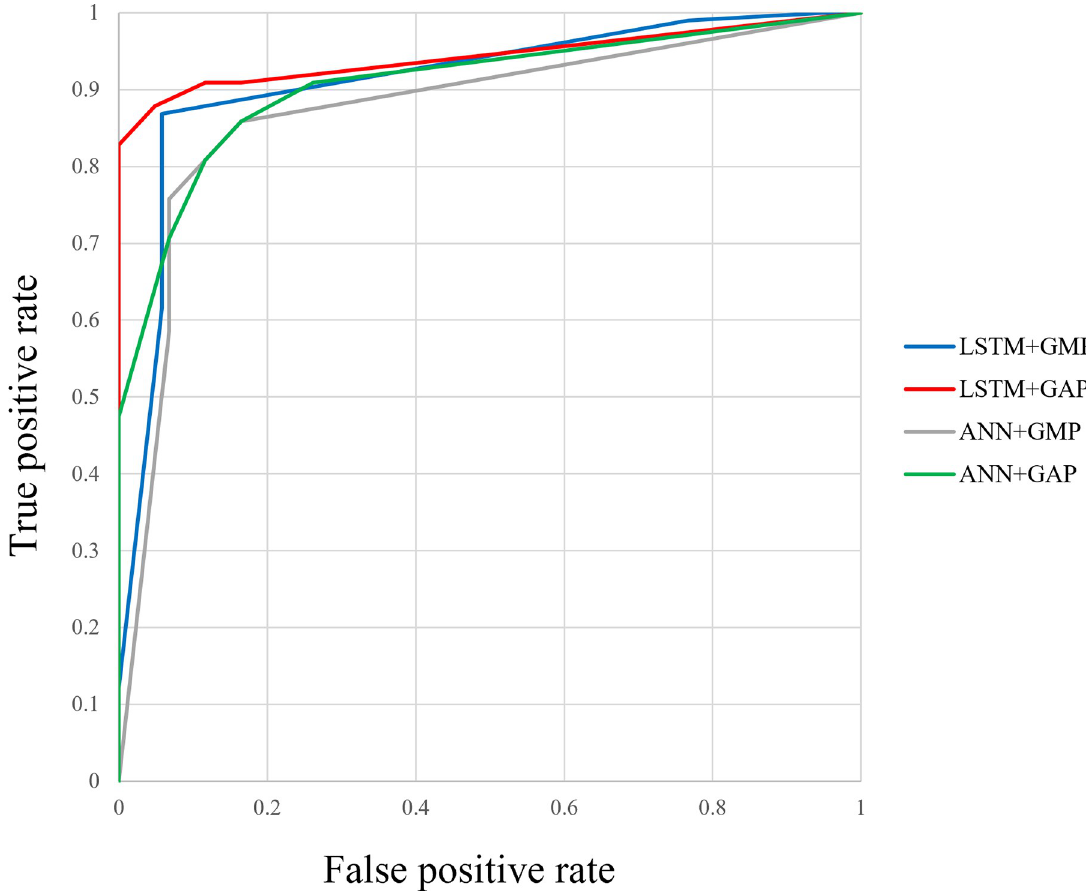
Fig 15. ROC curves of the GAP versus GMP in short-axis papillary muscle view.